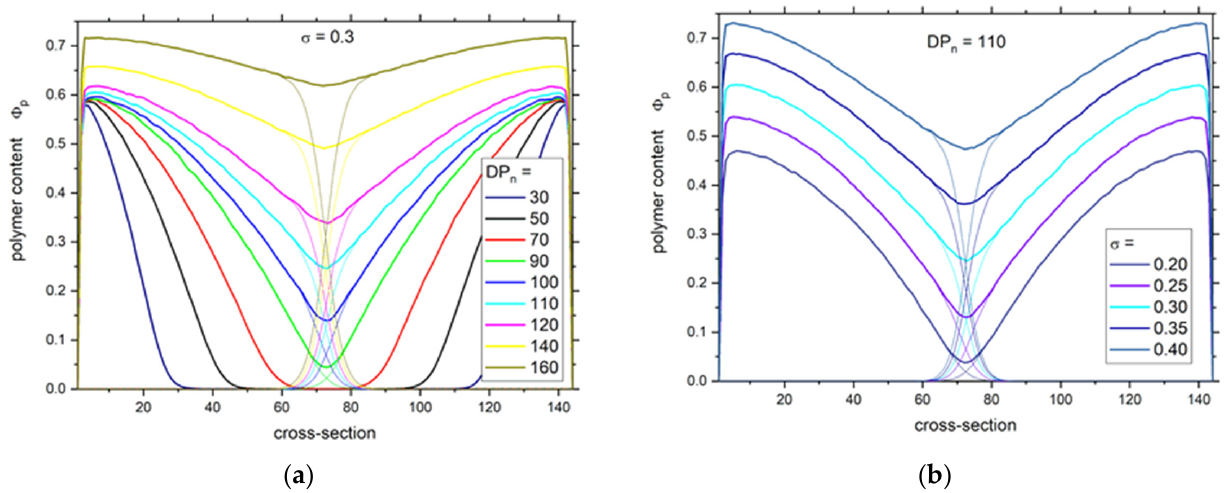
Figure 1. Polymer density profiles across the slit for different number averaged degrees of polymerization DP n ( a ) and for different grafting densities σ ( b ). Thick lines show total segment density (both brushes together) and thin lines represent the densities of single brushes.